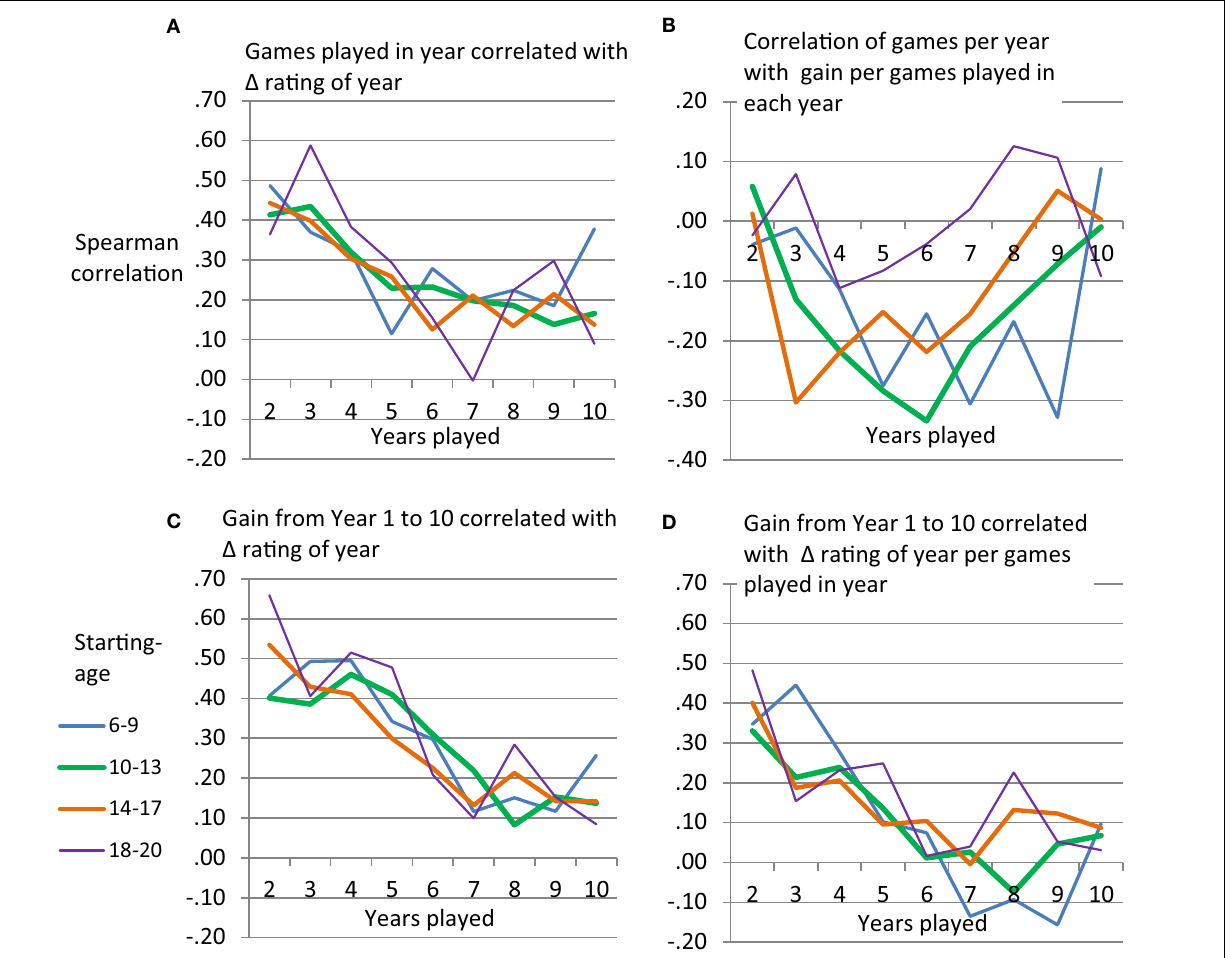
FIGURE 7 | Spearman rank order correlations per age group between performance variables taken from single years and rating gain per year (A,B) or overall rating gain